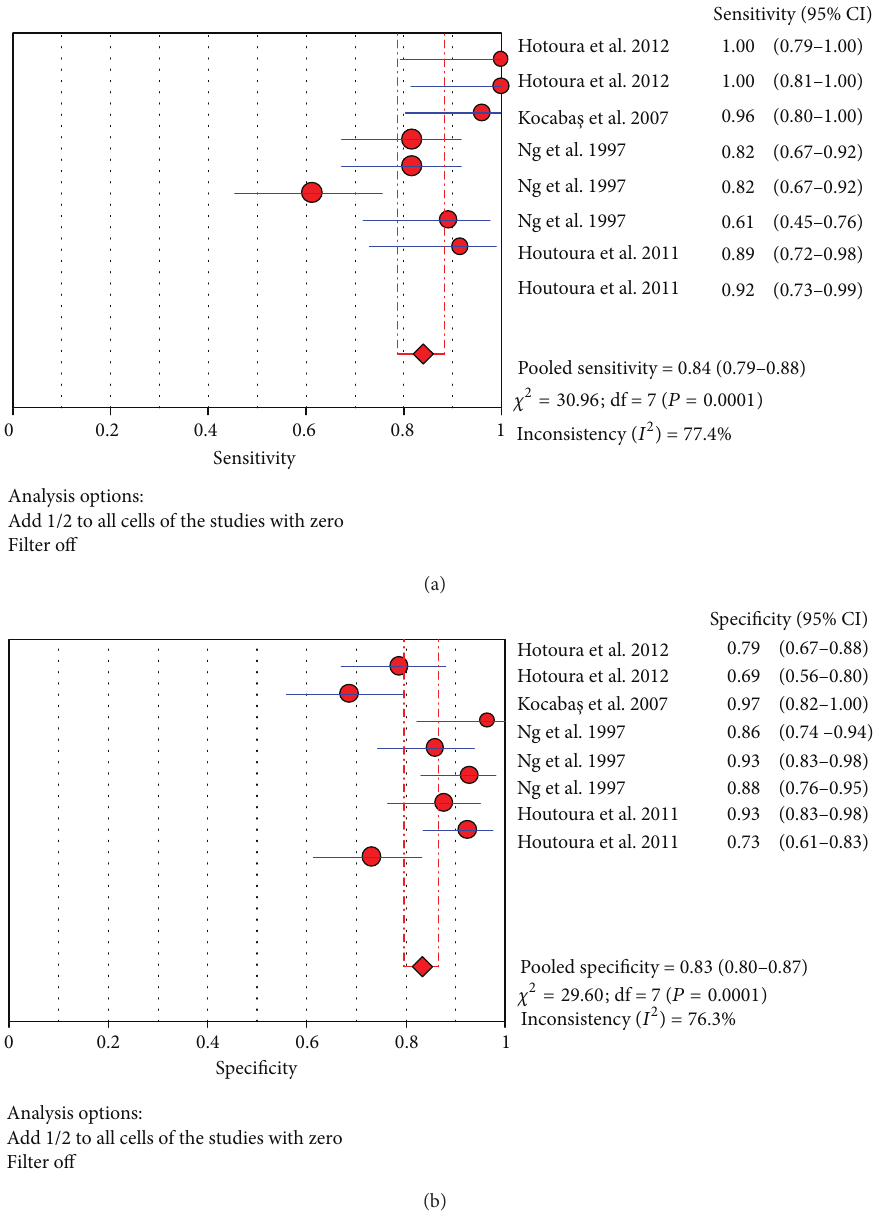
Figure 8: Forest plot for sensitivity and specificity of the TNF- 𝛼 test to diagnose neonatal sepsis at the LONS in the northern hemisphere.